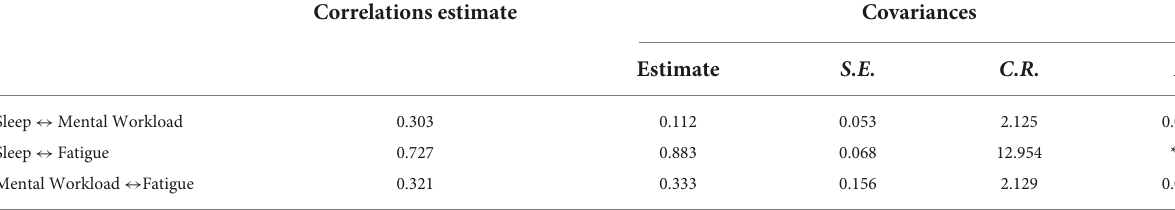
TABLE 1 Correlation coefficient, covariance and covariance significance among sleep, fatigue and mental workload ( n = 1004). Correlations estimate Covariances Estimate S.E. C.R. P Sleep ↔ Mental Workload